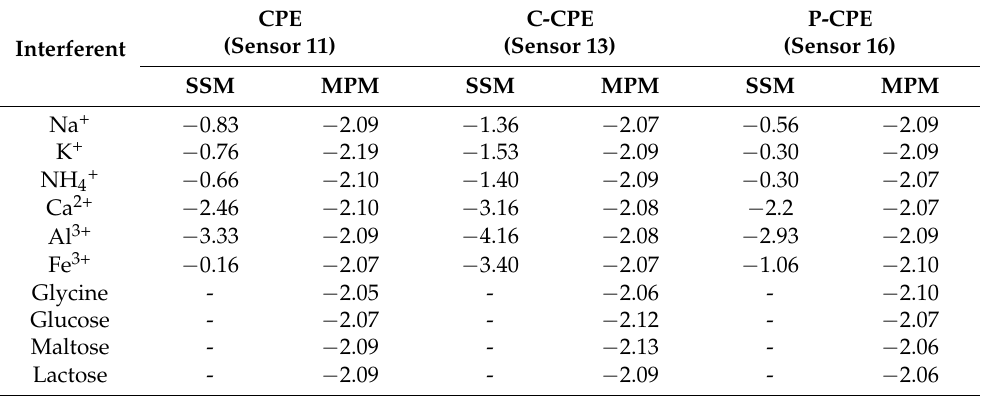
Table 3. Selectivity coefficient log, log K pot. 22 ± 2 ◦ C at pH 2.2.